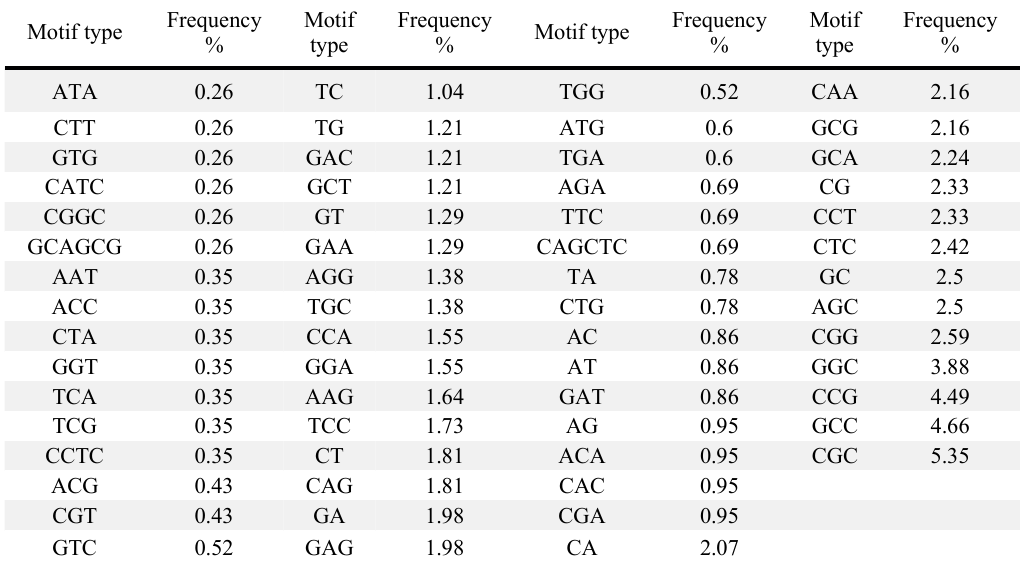
Table 1 . Frequency of main types of SSRs found in this study.